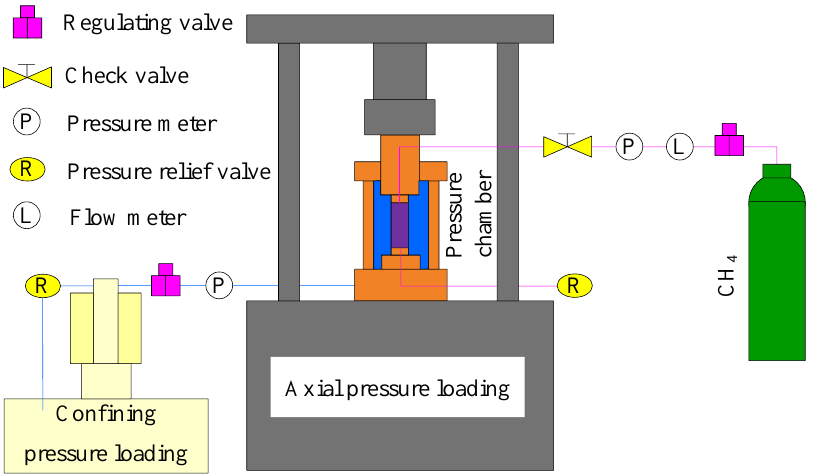
Figure 3. Schematic diagram of the permeability measurement test principle.